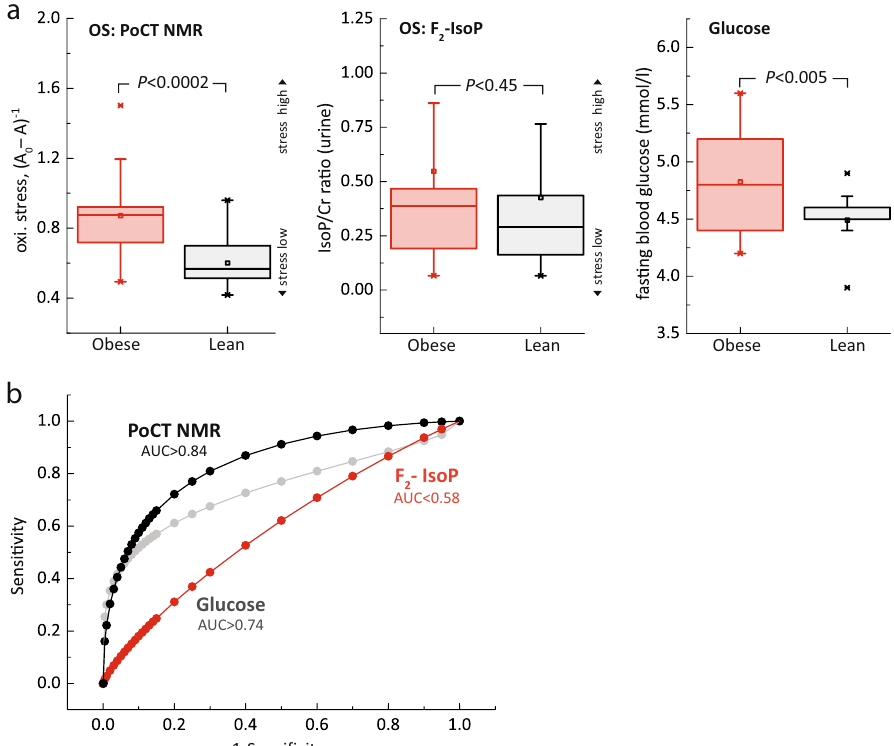
Fig. 8 Performance analysis of the proposed markers. a The normalized concentration of oxidative stress (OS) in red blood cells, oxidative stress in urine F 2 -IsoP, and fasting blood glucose for obese subgroup (red) and lean subgroup (black). The oxidative stress in urine were corrected for urine creatinine concentration (F 2 -IsoP/Cr ratio). The statistical signi fi cance was calculated using the Student ’ s T-test (two-tailed, unequal variance). The data is represented by box-plot format. b The receiver operating characteristic (ROC) of the respective biomarkers; PoCT NMR (black), fasting glucose (gray), and urine F 2 -IsoP (red). Area under the curve (AUC) of larger than 0.8, 0.6, and 0.4 was considered as good, medium, and